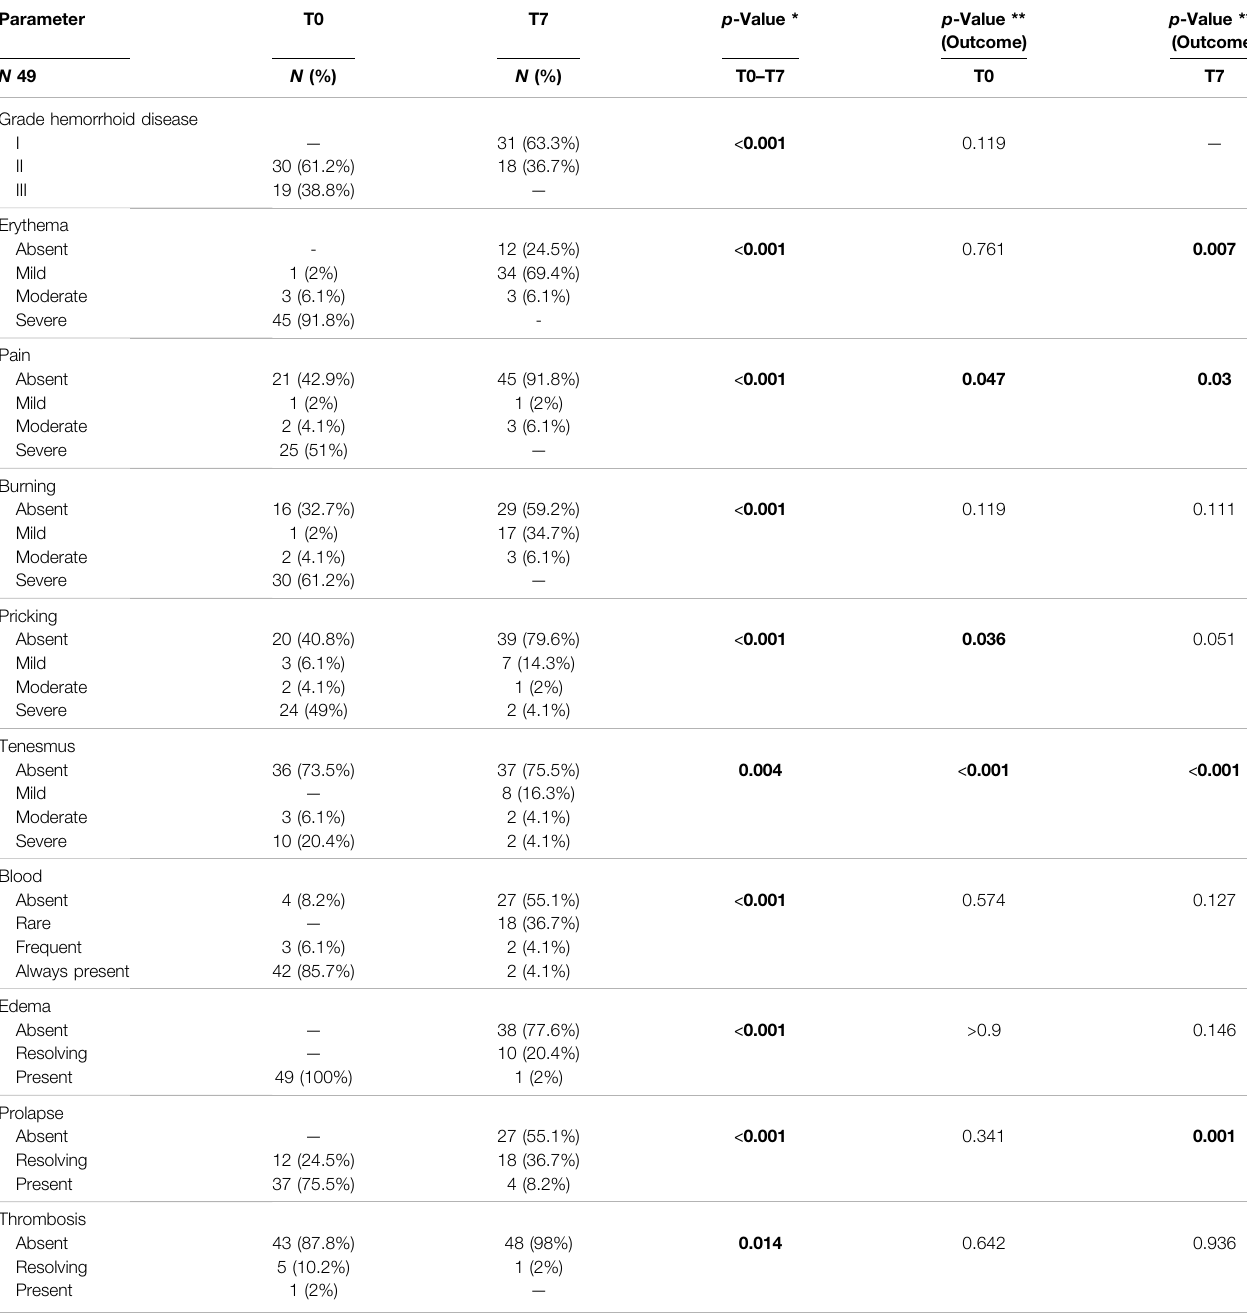
TABLE 2 | Presentation of changes in hemorrhoidal symptoms at different times of the study, at baseline (T0) and after 7 days of treatment (T7).